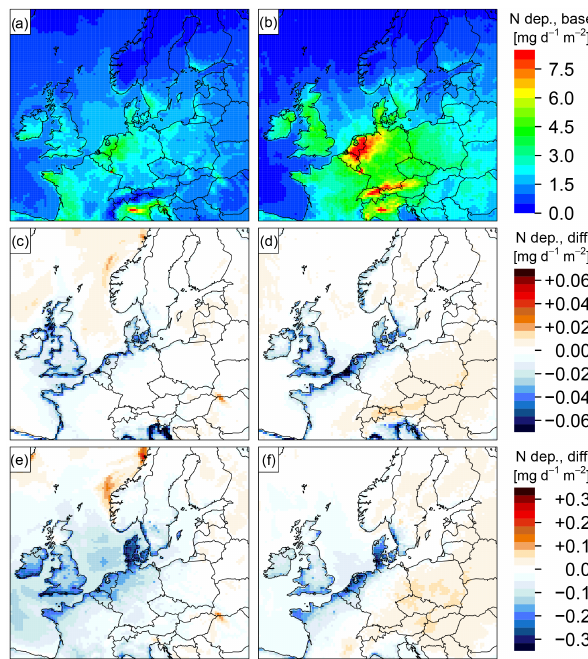
Figure 9. Total nitrogen deposition (dry plus wet deposition) in mgNm − 2 d − 1 in the study region during winter (a, c, e) and dur- ing summer (b, d, f) . (a, b) Nitrogen deposition in the base case; (c, d) nitrogen deposition difference between noSurf and base case (noSurf – base); (e, f) nitrogen deposition difference between zero and base case (zero – base). Note: The color scale of the plots (c) and (d) is different from that of the plots (e) and (f)